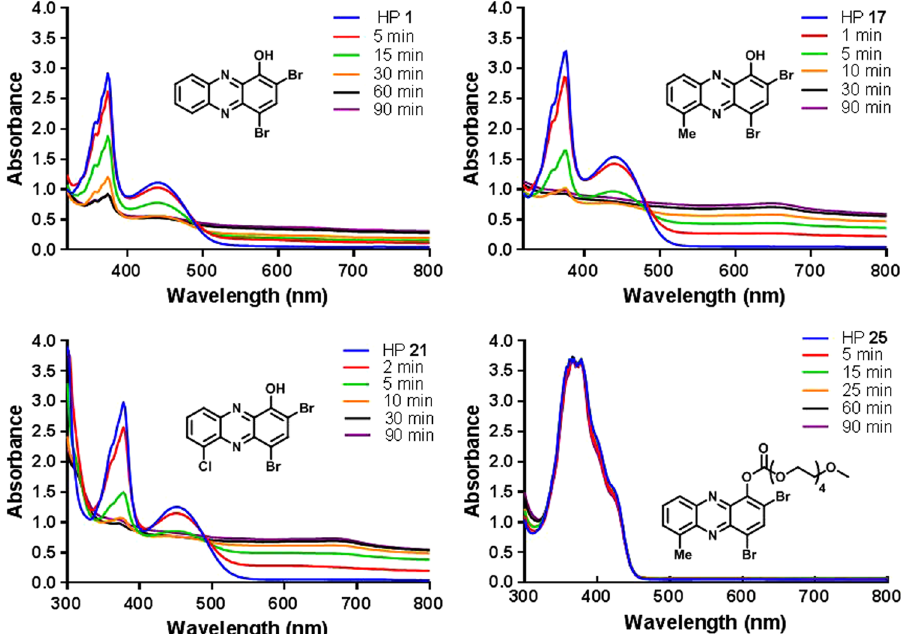
Figure 6. UV-Vis analysis of copper(II) binding various halogenated phenazines. The HP:copper(II) complex is insoluble and precipitates out of solution, thus the disappearance of HP peaks is clear while there is not a strong appearance of HP:copper(II) complex in the UV-Vis spectrum.